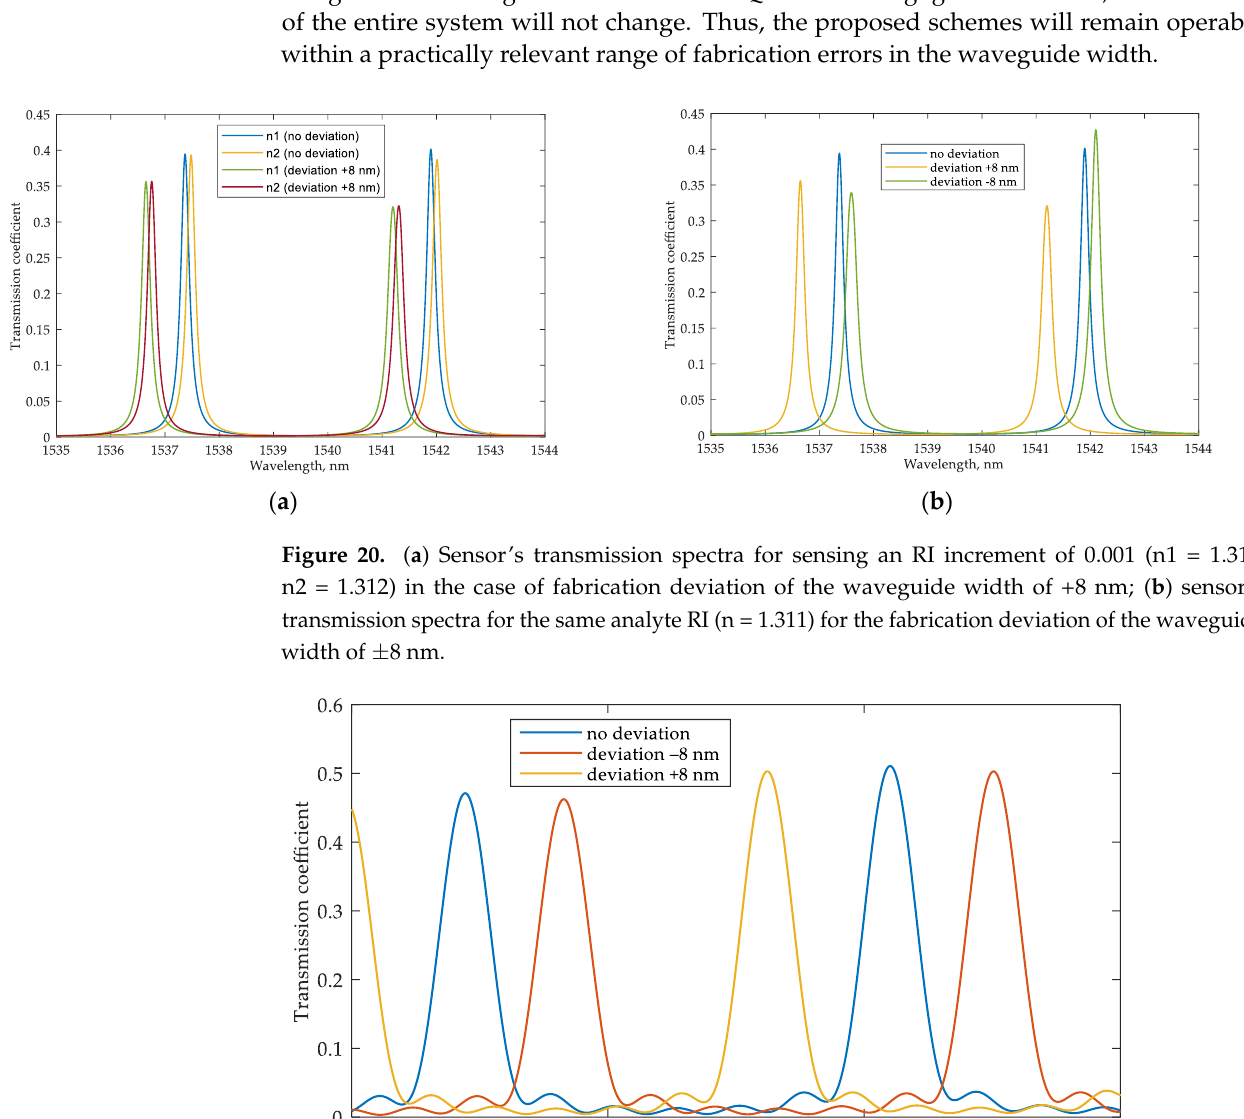
Figure 21. Interrogator ’ s transmission spectra for the fabrication deviation in the waveguide width of ±8 nm.